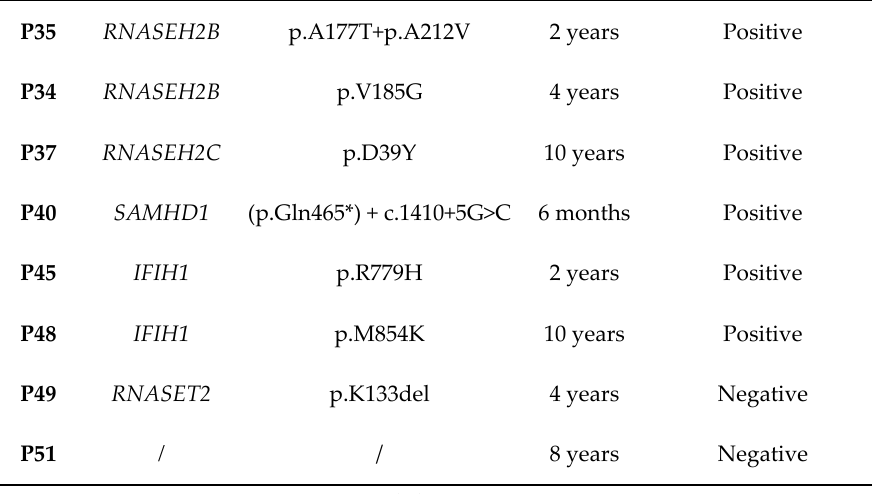
Figure 2. ( A ) Quantitative reverse transcription PCR of six ISGs IFI27 , IFI44 , IFIT1 , ISG15 , RSAD2 and SIGLEC1 in whole blood measured in 18 patients with Aicardi-Goutières syndrome and 31 controls. The threshold is calculated at 2.216: Higher values are considered positive, whereas lower scores are negative. ( B ) Interferon scores of 12 RNASEH2B mutated patients and 31 healthy controls. Scores above the threshold are positive whereas those below are negative. ( C ) Interferon signatures of 18 AGS patients.